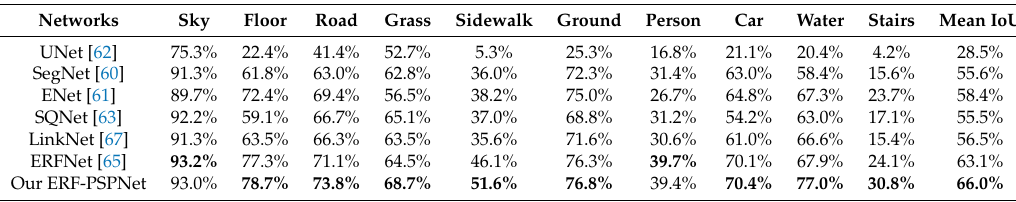
Table 3. Accuracy analysis on ADE20K